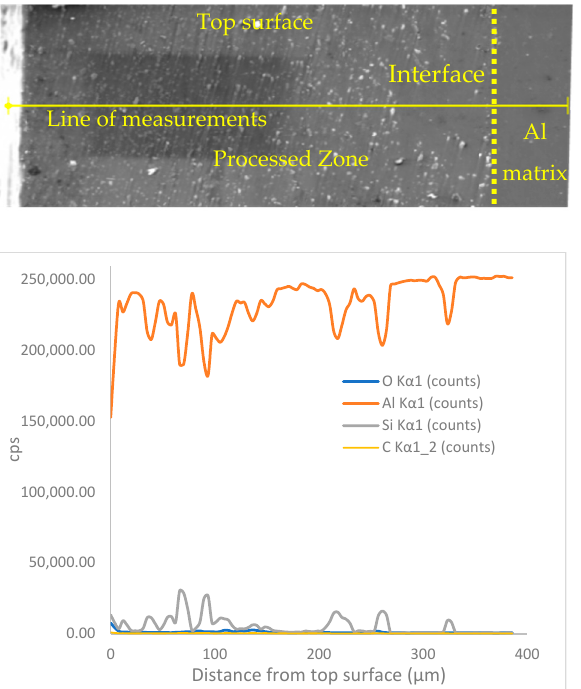
Figure 8. Vertical line EDS spectrum at the center of the surface composite starting from the top surface of the composite layer to the composite/matrix interface.